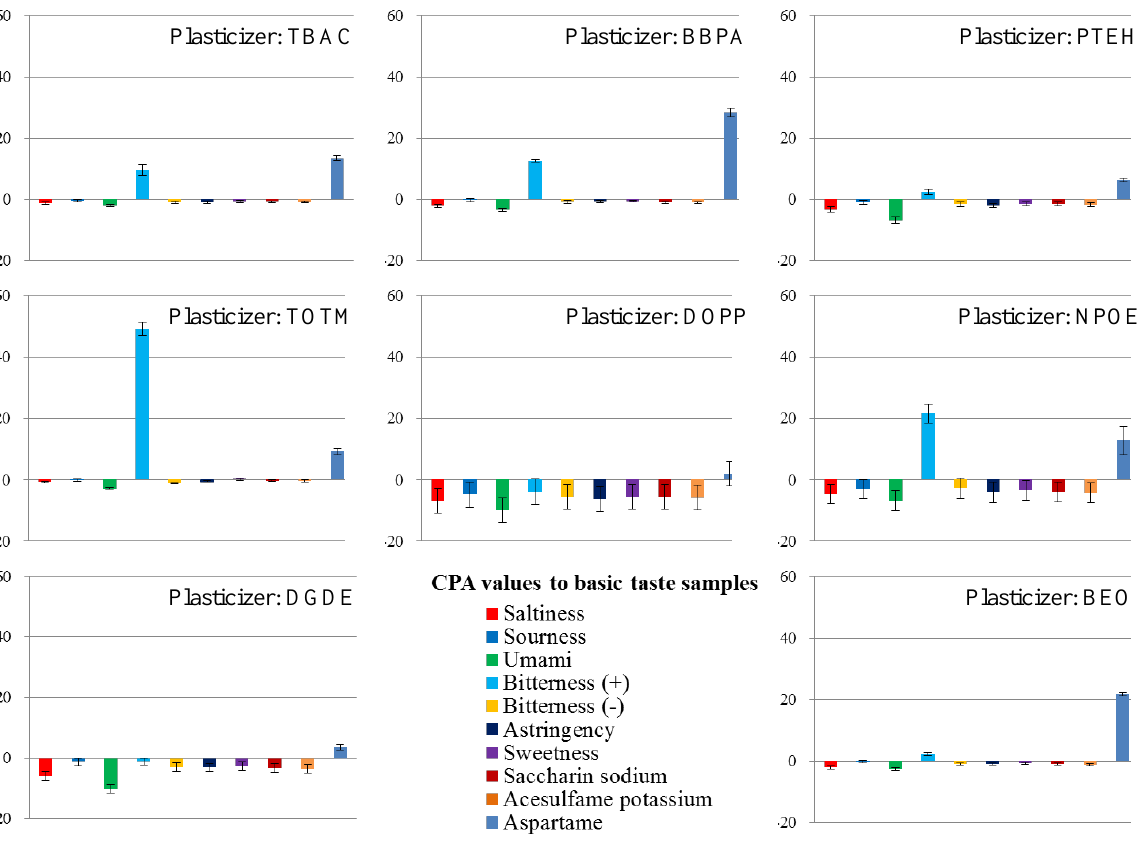
Figure 7. CPA values: basic taste samples were measured using 8 kinds of lipid/polymer membrane (parameter of membranes: type of plasticizer).